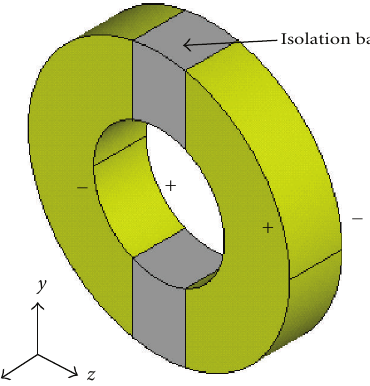
Figure 3: Model of a new piezoceramic ring.